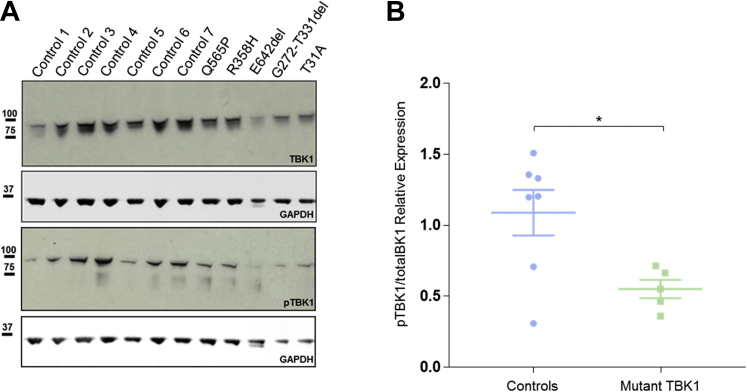
Patient-derived LCLs harboring TBK1 variants show a reduced level of TBK1 phosphorylation. (A top) Western blot of control- and patient-derived LCLs, harboring 5 different TBK1 variants, showing the level of total TBK1. (A bottom) Western blot showing phospho-TBK1 expression in patient- and control-derived lymphoblasts. (B) Dot plot showing a significant difference in the ratio of phospho-TBK1 and total TBK1 between control- and patient-derived LCLs (analyzed by unpaired t-test, 2 tailed, p = 0.0229). Abbreviations: LCL, lymphoblastoid cell line; TBK1, tank binding kinase 1. * p = 0.0229.